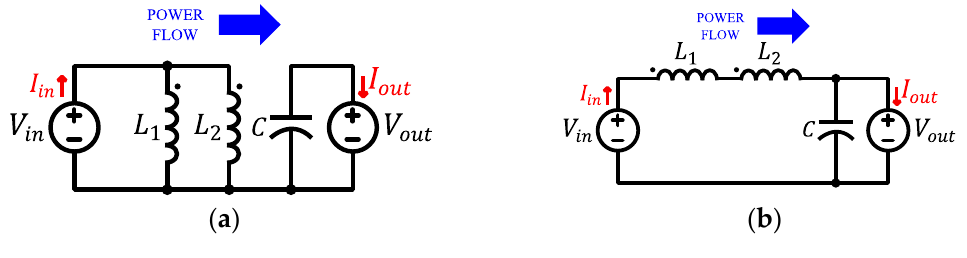
Figure A1. Boost mode operation. ( a ) Switching state 1. ( b ) Switching state 2.